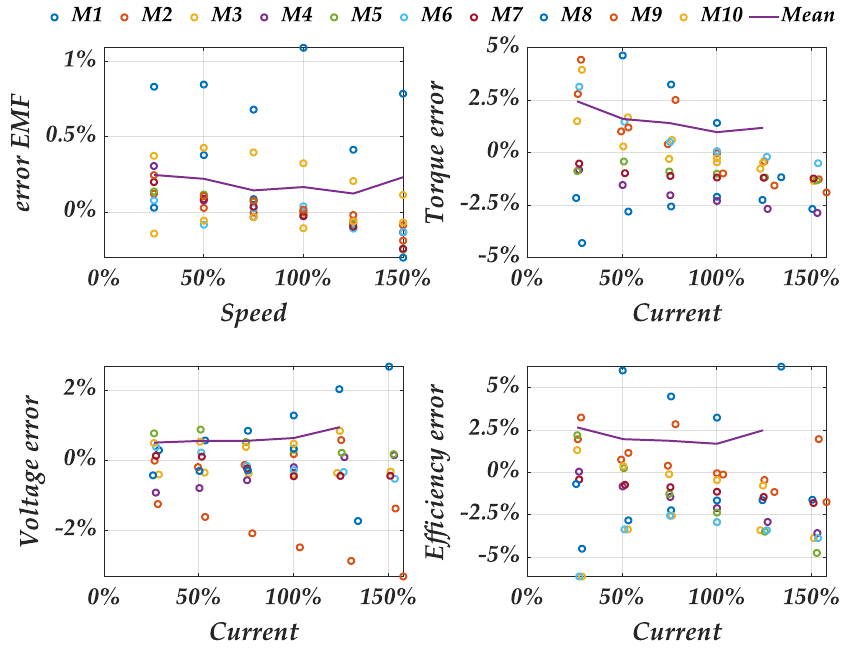
Figure 16. Error of the sizing tool computed as the difference in percentage between the experimental measurements and the results given by the sizing tool; error computed for the 10 sized